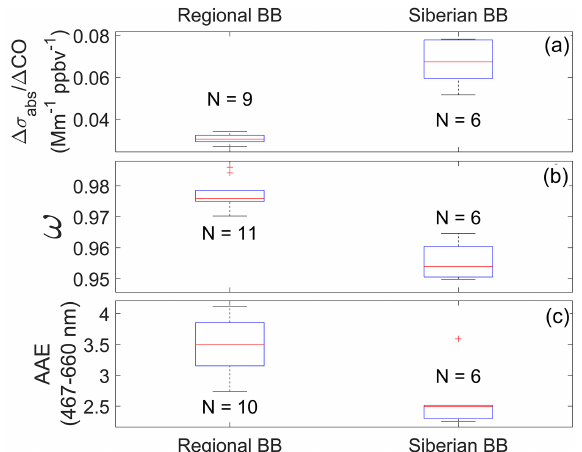
Figure 4. Box plots of (a) (cid:49)σ abs /(cid:49) CO, (b) single scattering albedo ( ω) measured at 528nm, and (c) absorption Ångström exponent (AAE) for absorption measurements at 467 and 660nm for regional BB events and Siberian-influenced events. N indicates the number of events for each box. Lower and upper whiskers represent the min- imum and maximum values, respectively. Lower and upper lines of the box represent the 25th and 75th percentiles, respectively. The red line in the middle of the box represents the median, and the red plus mark represents outliers.